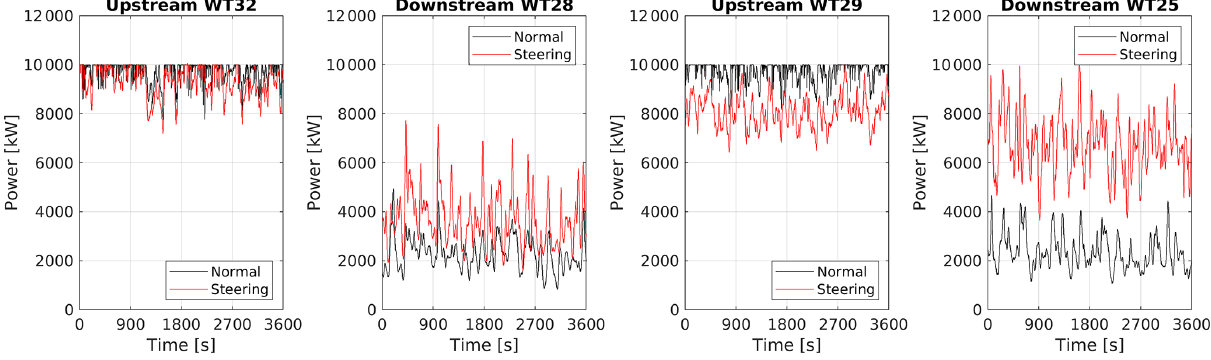
Figure 21. Power time series for the single-wake scenario in the TotalControl LES blind test for the four turbines: WT32–WT28 and WT29–WT28. Black corresponds to normal operation, while red is power production during wake